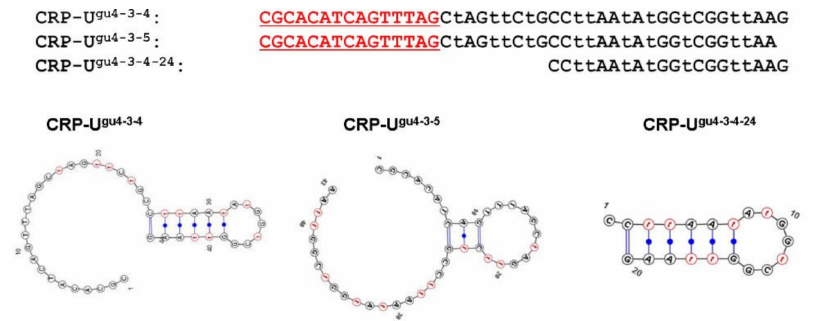
Figure A9. Predicted secondary structures of CRP–U gu4 − 3 truncated sequences (CRP–U gu4 − 3 − 4 , CRP–U gu4 − 3 − 5 , and CRP–U gu4 − 3 − 4 − 24 ) using the VALFold software and the general DNA parameters [37,38]. The letter “t” indicates U gu